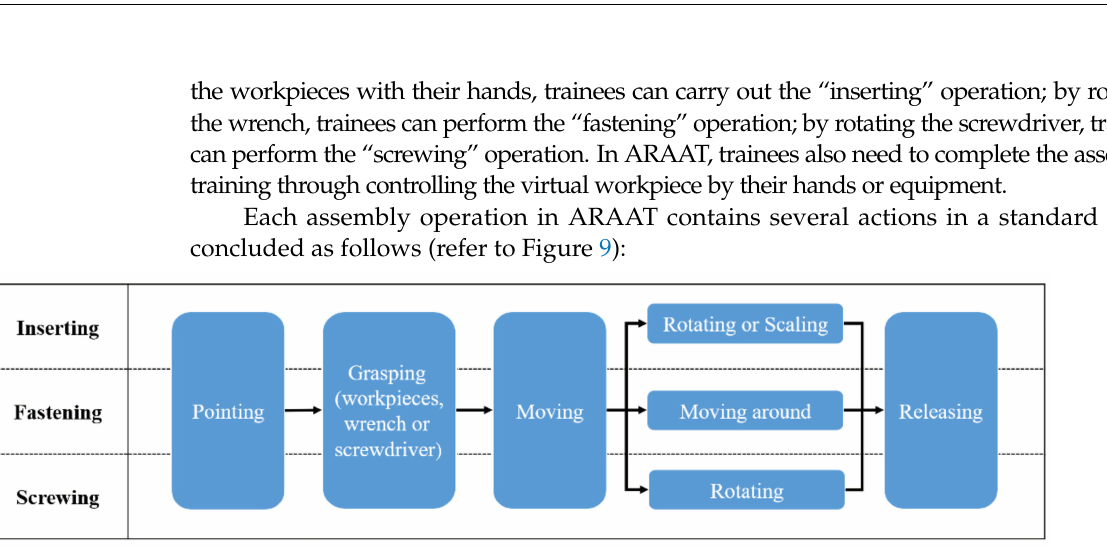
Figure 9. The action orders of three typical operation “inserting”, “fastening”, and “screwing” in ARAAT.